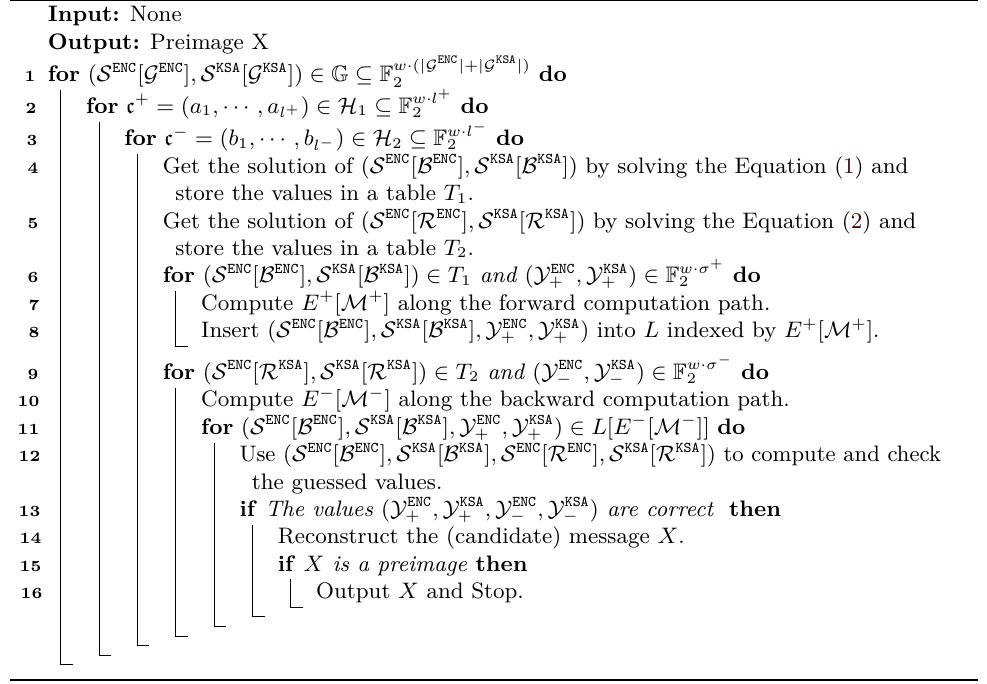
Algorithm 1: Sasaki et al.’s MITM preimage attack with